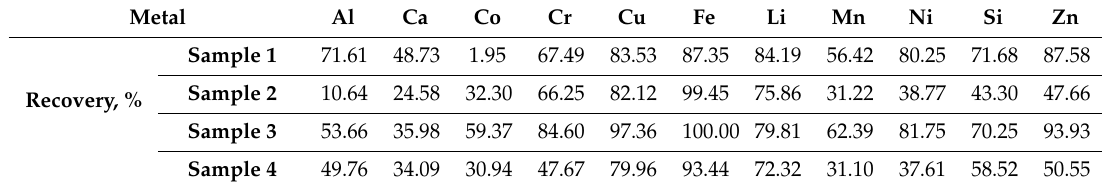
Table 3. Degrees of metal recovery from solutions after acidic reductive